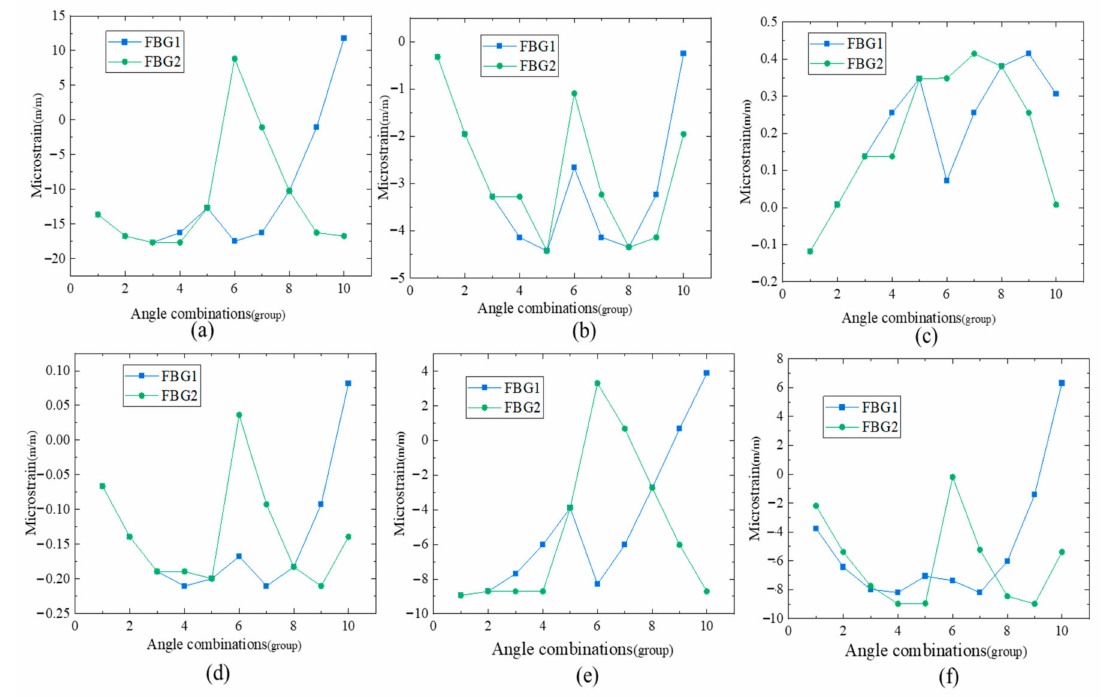
Figure 4. Double FBG strain variation diagram of measuring point 7: ( a ) Load loading mode 1; ( b ) Load loading mode 2; ( c ) Load loading mode 3; ( d ) Load loading mode 4; ( e ) Load loading mode 5; ( f ) Load loading mode 6.